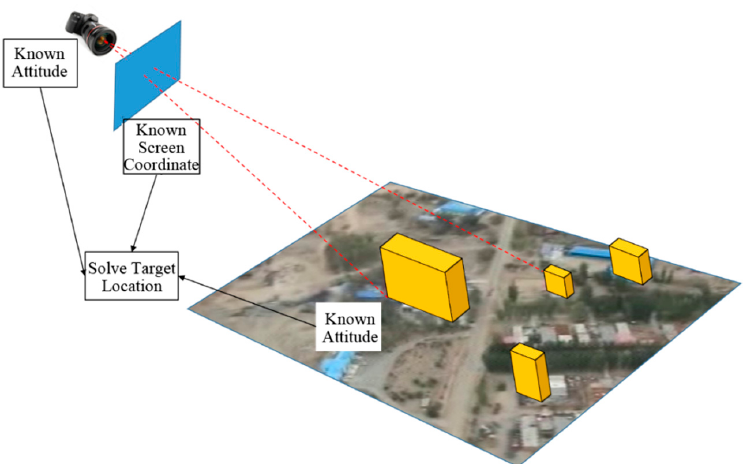
Figure 4. Target localization principle based on the GPS data and the attitude data of the UAV.